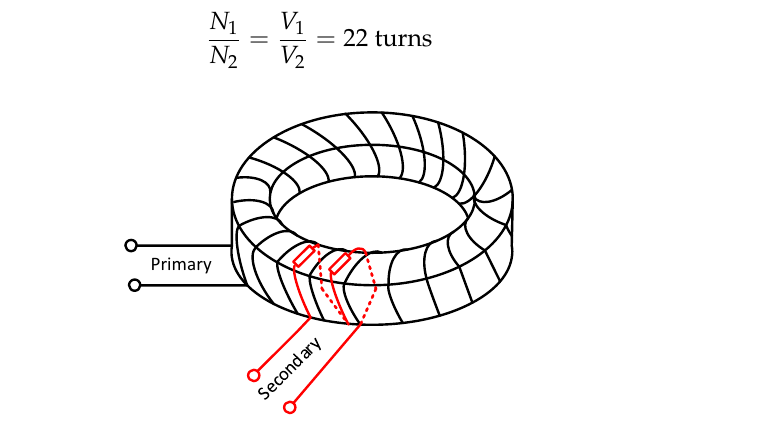
Figure 5. Schematic of the core with the primary and one